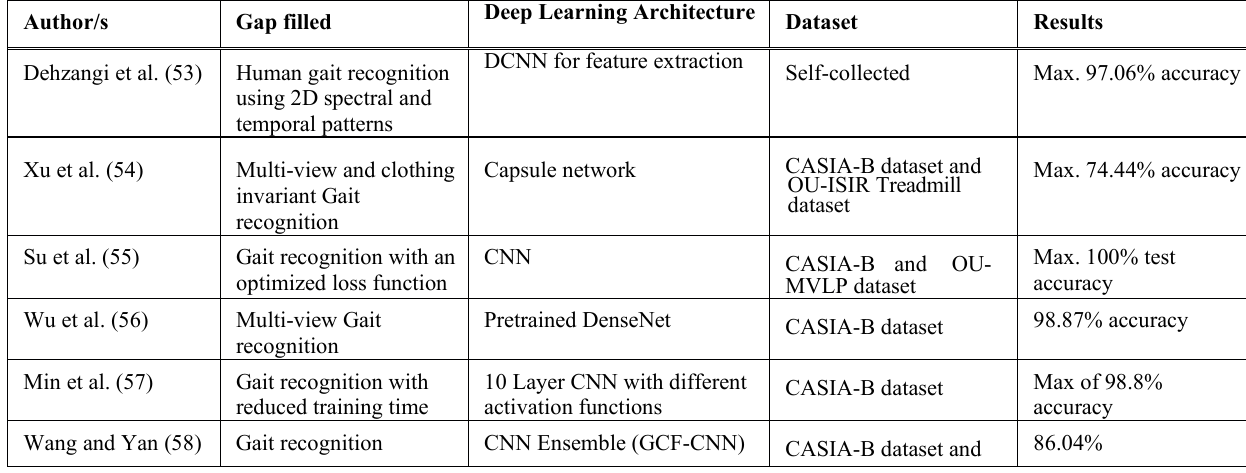
Table 6. Important works on Gait based identification using deep